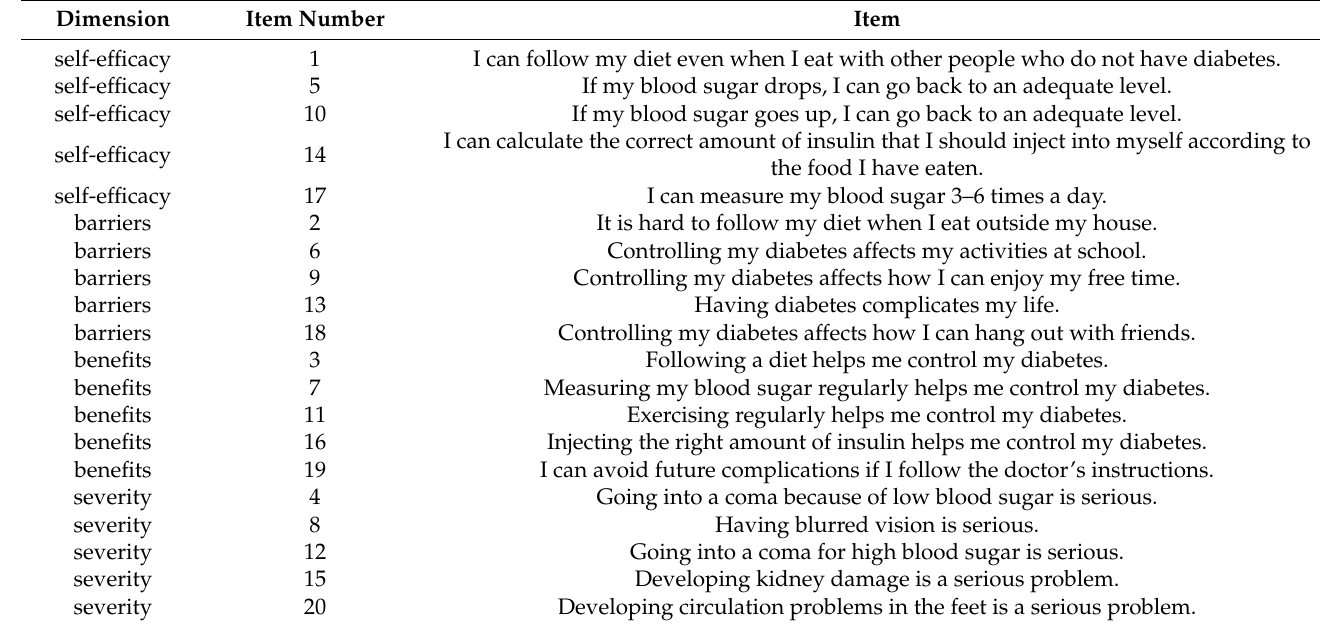
Table 2. Adapted Health Belief Model (HBM)-T1DM items and